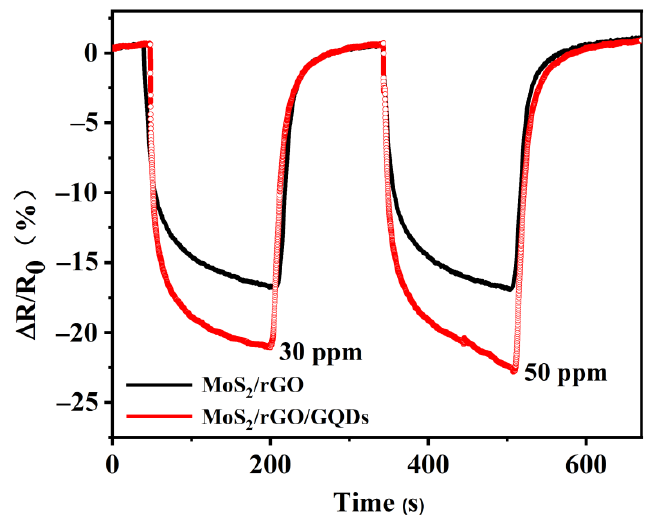
Figure 8. Response and recovery curves of MoS 2 /rGO and MoS 2 /rGO/GQD-based sensors exposed to 30 and 50 ppm NO 2 .